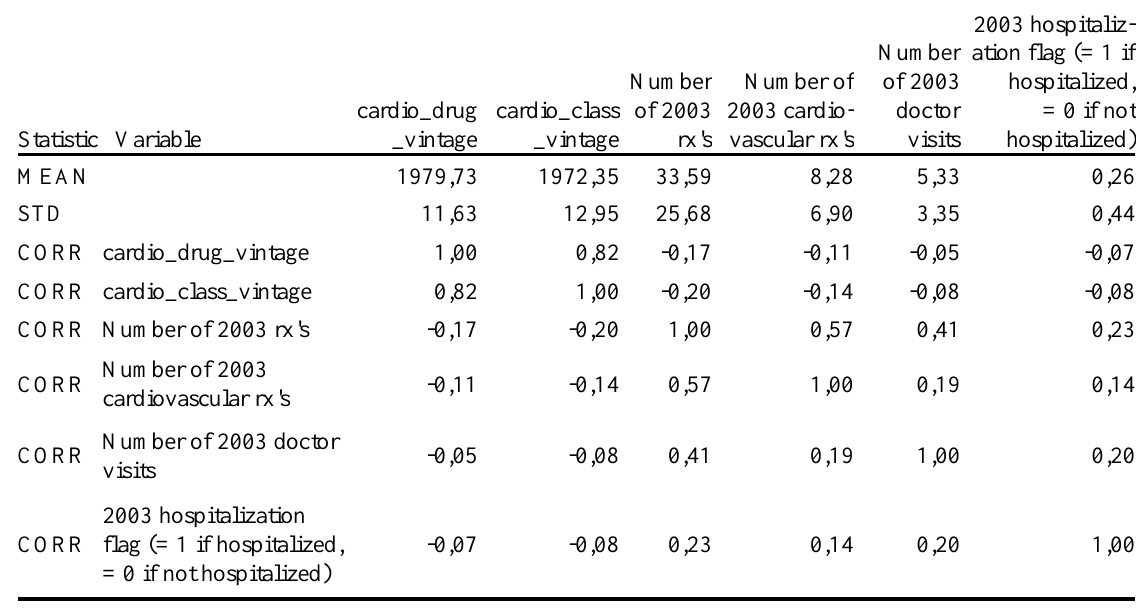
Table 7: Summary statistics: vintage of cardiovascular drugs and drug classes and quantity of medical services used in 2003 (N = 23,686) Panel A. Unweighted means, standard deviations, and correlation coefficients